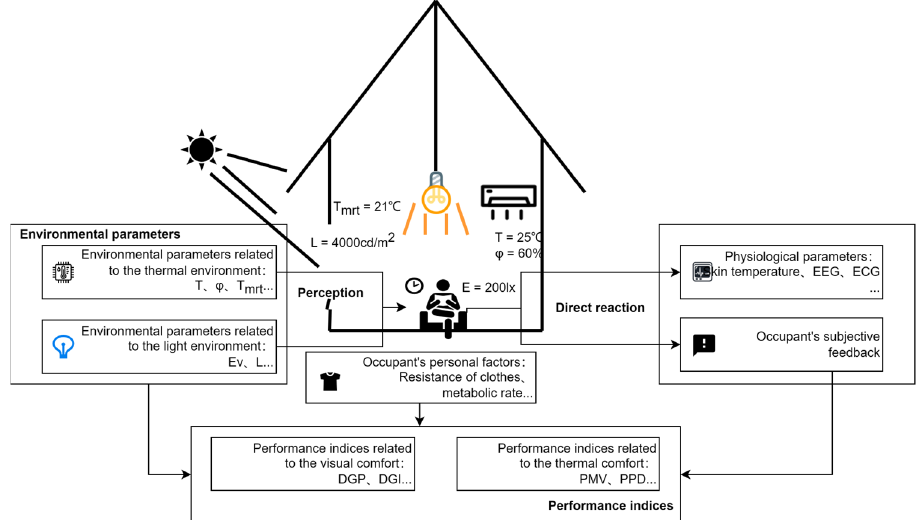
Figure 3. Relationship between parameters, indices and the occupant’s